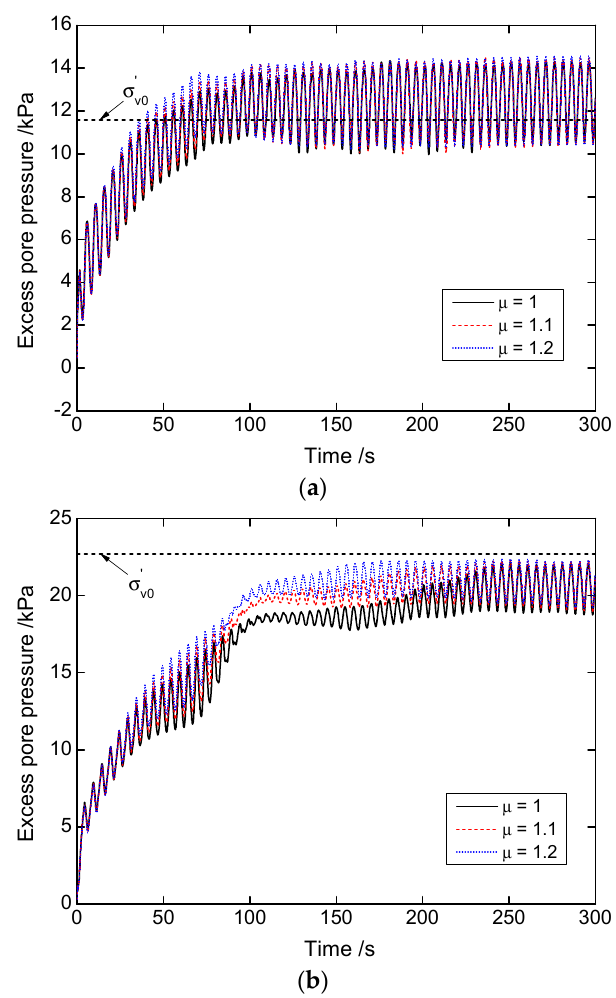
Figure 6. Time traces of excess pore pressure: ( a ) point A; ( b ) point B.